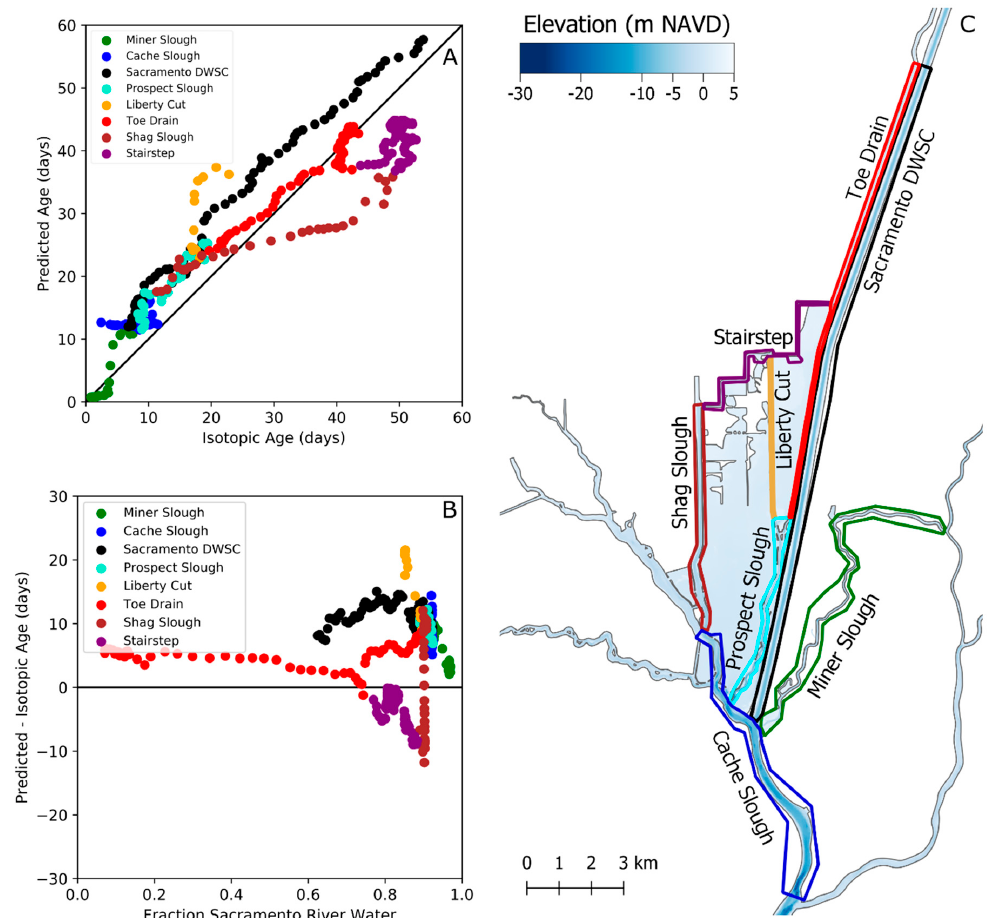
Figure 8. ( A ) Relationship between predicted and isotopic age at the time and location of continuous underway measurements. ( B ) The difference between predicted and isotopic water age plotted against fraction of Sacramento River water at each sampling location. ( C ) The polygons defining regions referenced in panels (A) and (B).